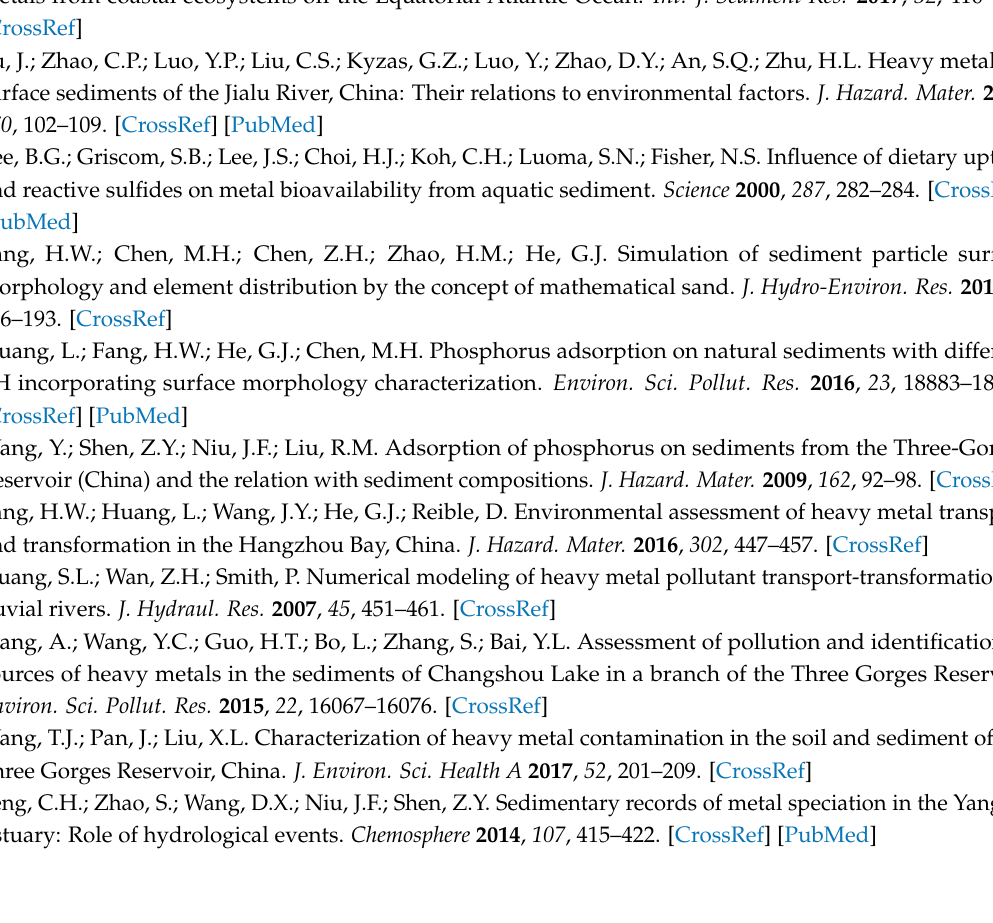
s1, Figure S1: Land use in the region of Three Gorges Reservoir, Table S1: Location of the sampling sites and the measured environmental variables, Table S2: A more detailed comparison with the results of Xu et al. (1999) for the sites affected by urban